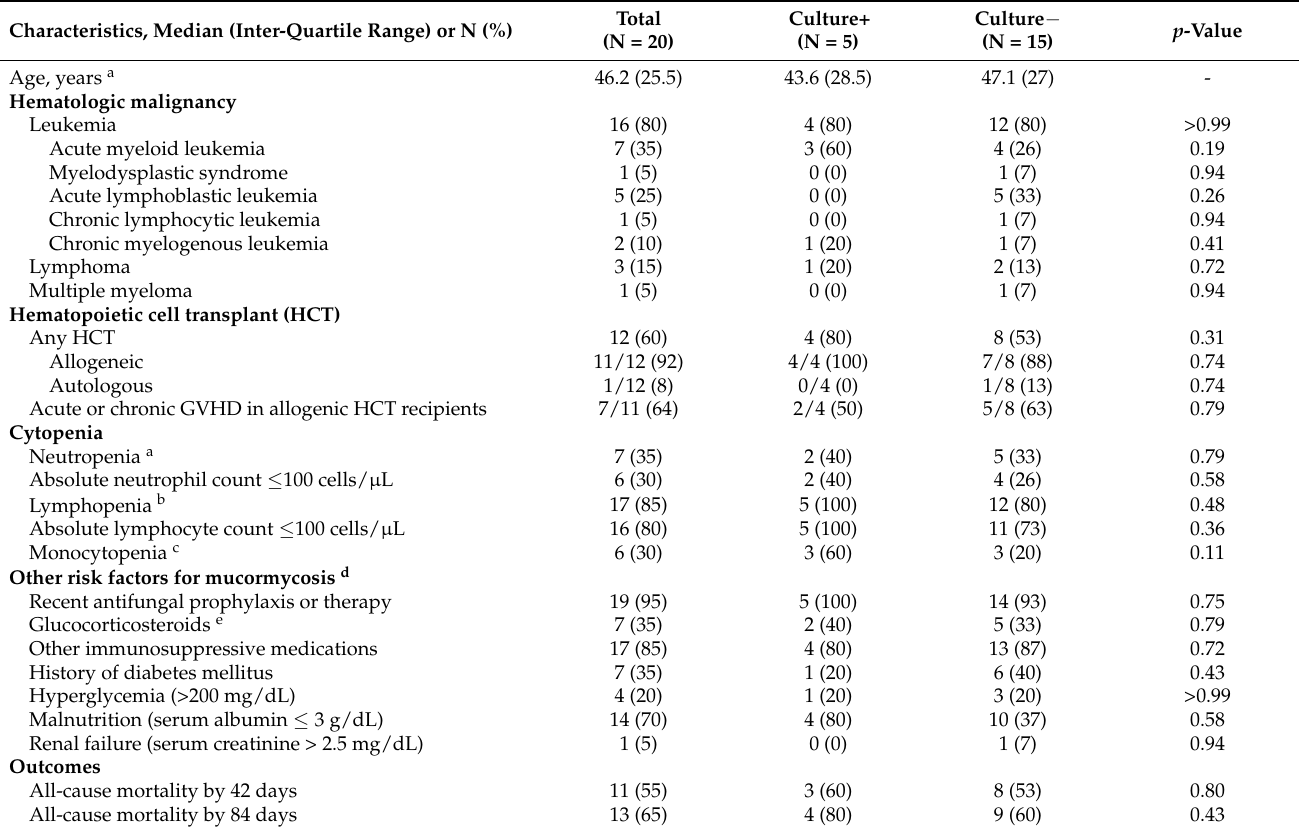
Abbreviations and footnotes for Table 2. Abbreviation: GVHD = graft-versus-host disease. Footnotes: a